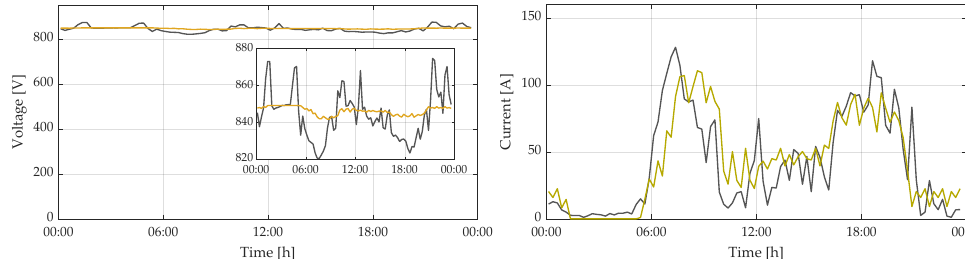
Figure 12. Measurement (black) and simulations (yellow) of voltage ( left ) and current ( right ) in TS T-T in an average window of 15 min. The plots cover a 24-h simulation scenario.